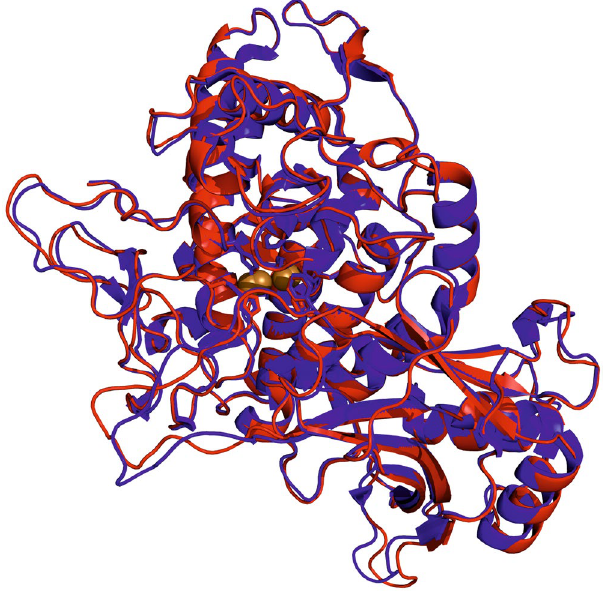
Figure 6. Alignment of Ab PPO4 isolated from the natural source and the recombinant enzyme. The latent chain of Ab PPO4 isolated from Agaricus bisporus (PDB 4OUA, chain B; shown in blue) 36 was aligned with the heterologously produced protein (PDB 5M6B, chain B; shown in red). The r.m.s.d. between the positions of 3616 matched atoms amounts to 0.435